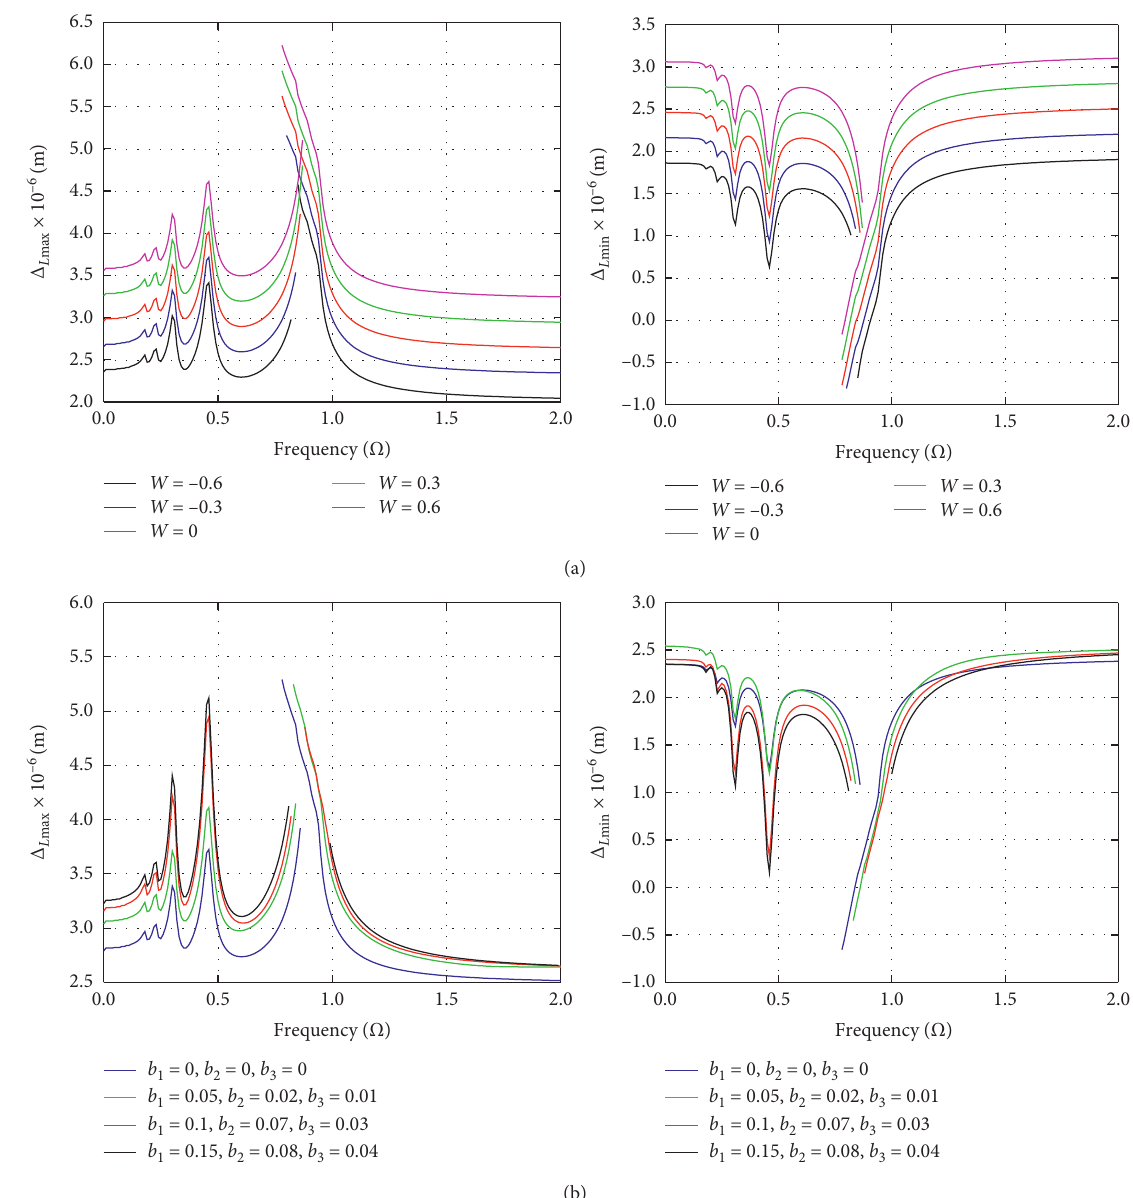
Figure 8: Amplitude frequency characteristic curve of the system under two kinds of backlash models. (a) Constant backlash models and (b) dynamic backlash